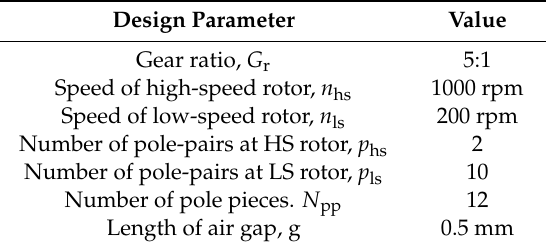
Table 1. Value of fixed parameters of the magnetic